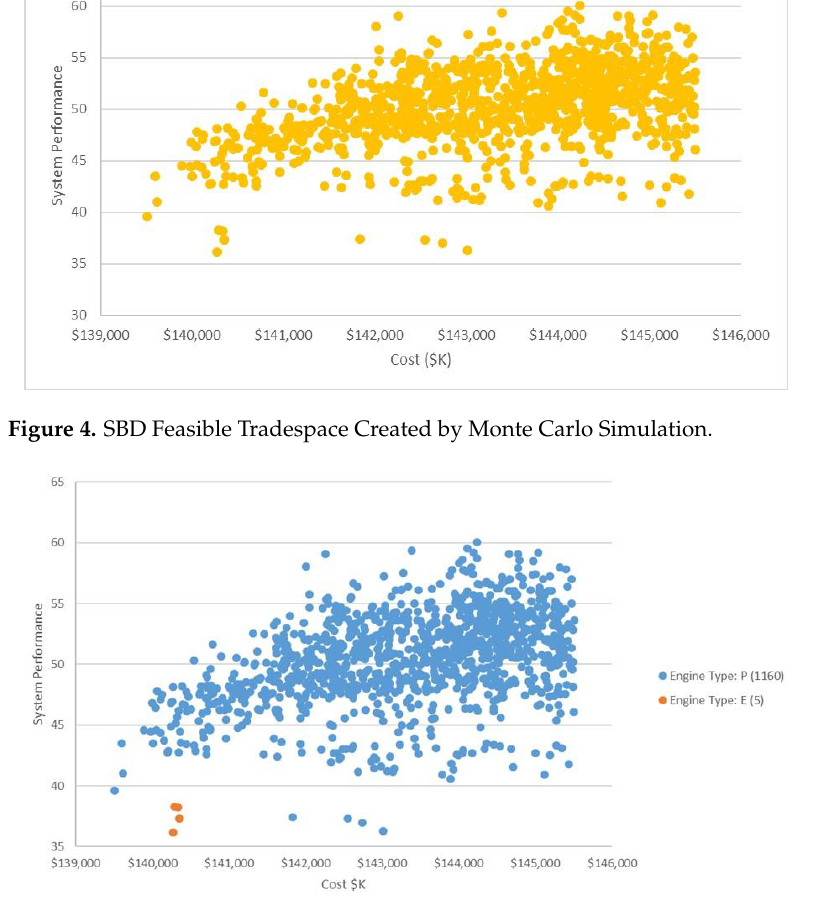
Figure 5. Tradespace Classified by Engine Type as Sets.